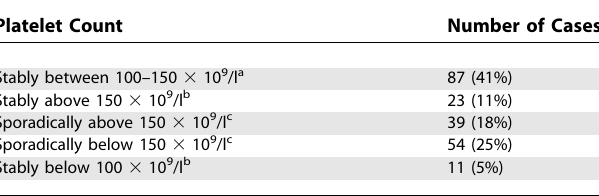
Table 2. Behavior of the Platelet Counts during the Initial 6-mo Monitoring Phase in 214 Individuals Who Completed the